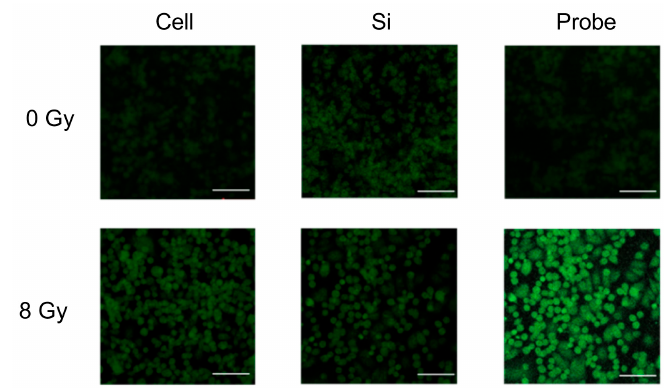
Figure 9. In the Terminal deoxynucleotidyl transferase (dUTP)-mediated nick end-labeling (TUNEL) assays, the three samples irradiated with 8 Gy showed stronger fluorescence intensity than the non-irradiated samples. The combination of PCSN probes and 8-Gy irradiation produced the strongest fluorescence intensity. Scale bars represent 100 µm. Cell: SK-BR3 cells alone; Si: cells in medium containing 1200 ppm PCSNs; Probe: cells in medium containing 1200 ppm PCSN probes.